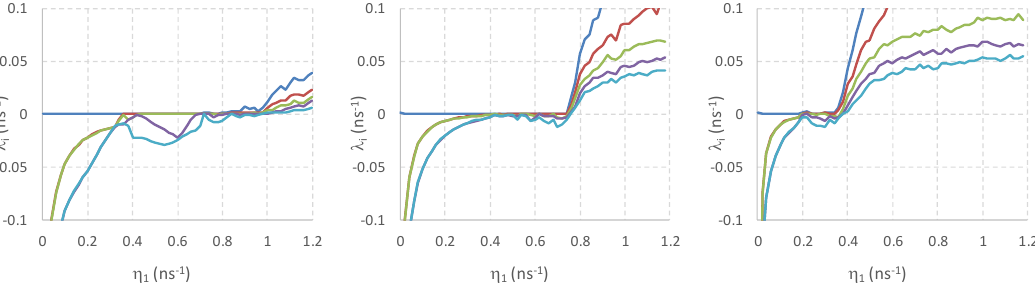
Figure 8. The five largest Lyapunov exponents: without FOF (i.e., η 2 = 0 ns –1 ) (left), with FOF (i.e., η 2 = 3 ns –1 ) (middle) and with large FOF strength (i.e., η 2 = 8 ns –1 ) (right).